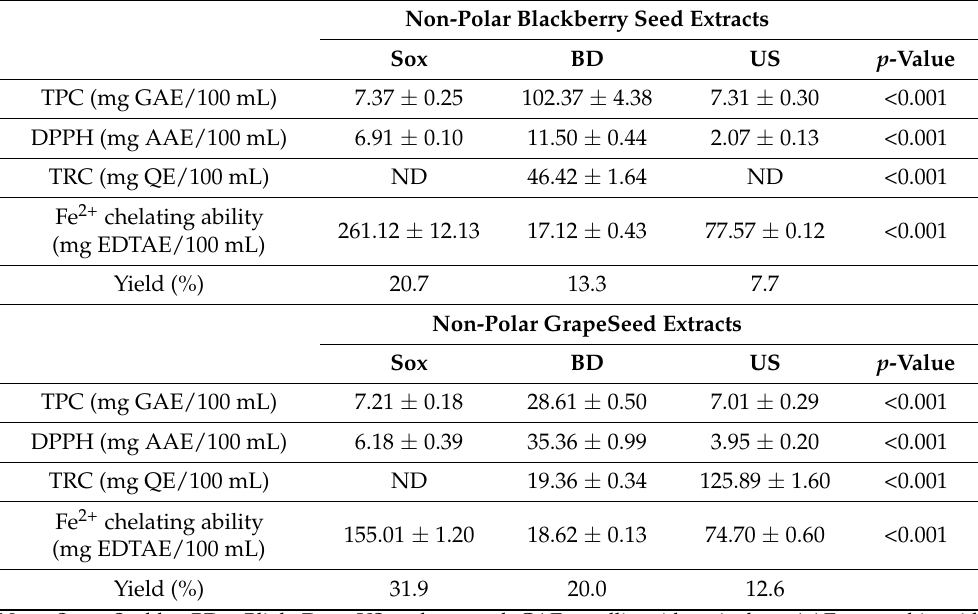
Table 1. Total phenolic content and antioxidant activity of non-polar blackberry and grape seed